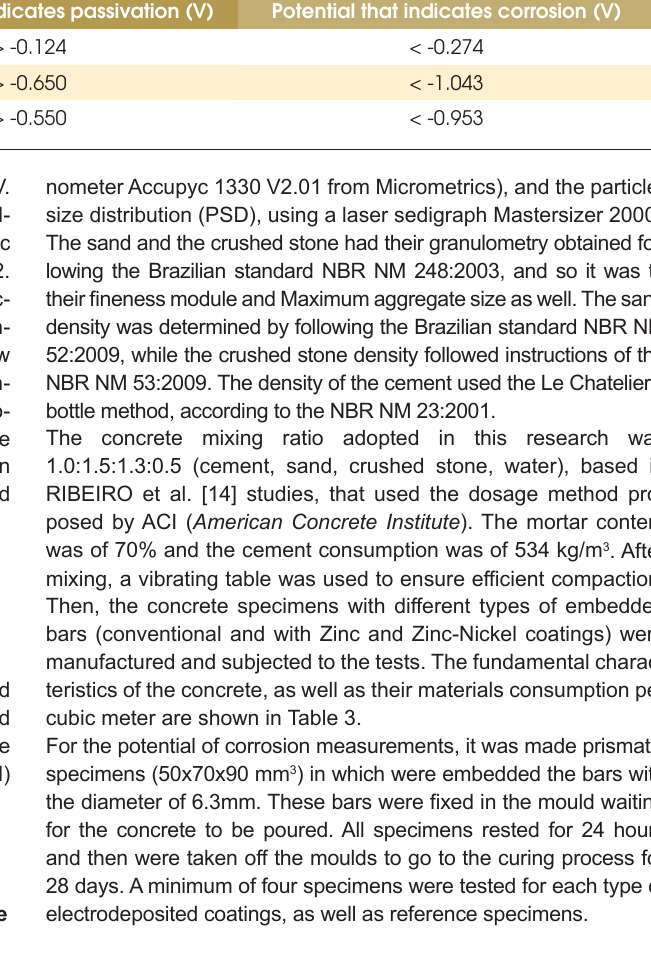
Table 2 – Potential of corrosion zones indicating the high probabilities of corrosion or passivation according with the surface condition (using as reference the SCE) Surface condition Conventional steel bar